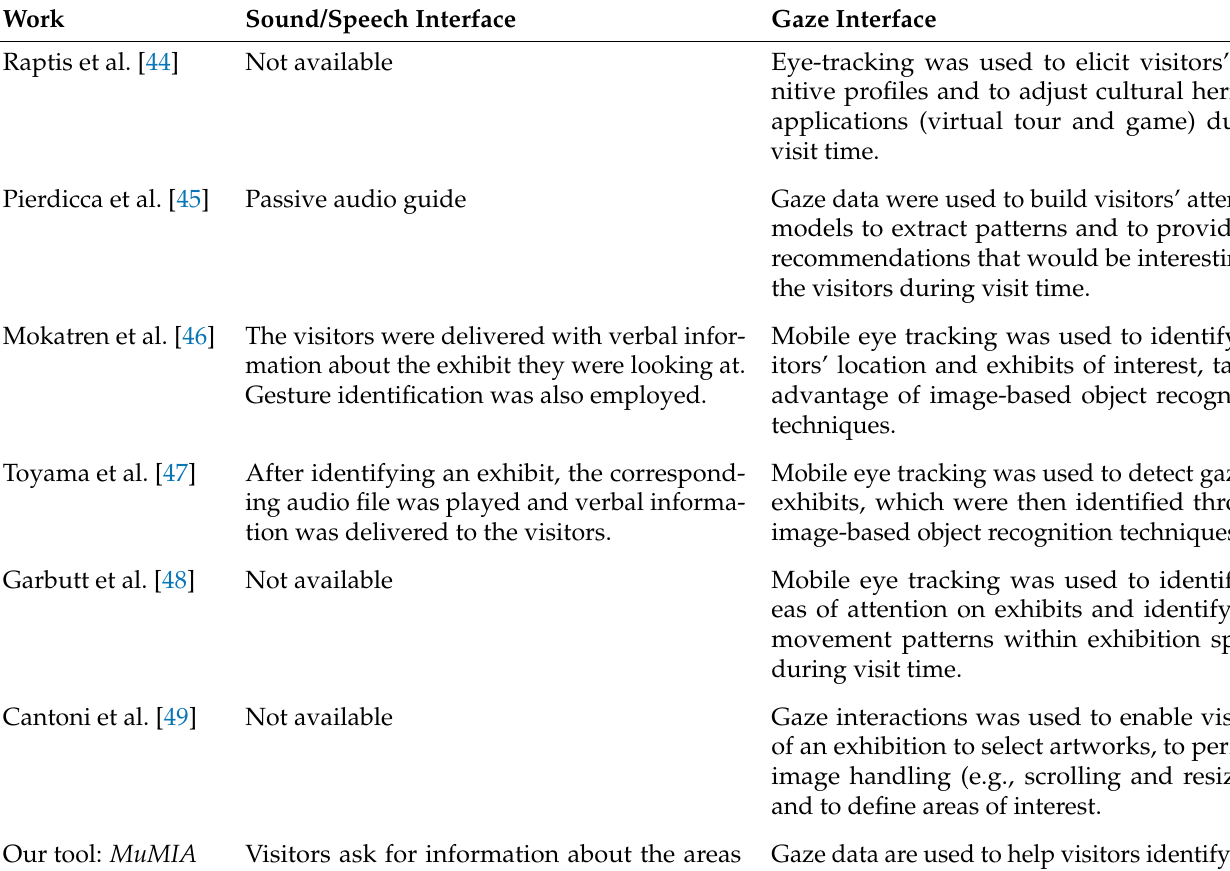
Table 1. Comparison between our proposed tool ( MuMIA ) and other tools in cultural heritage that are primarily based on active eye